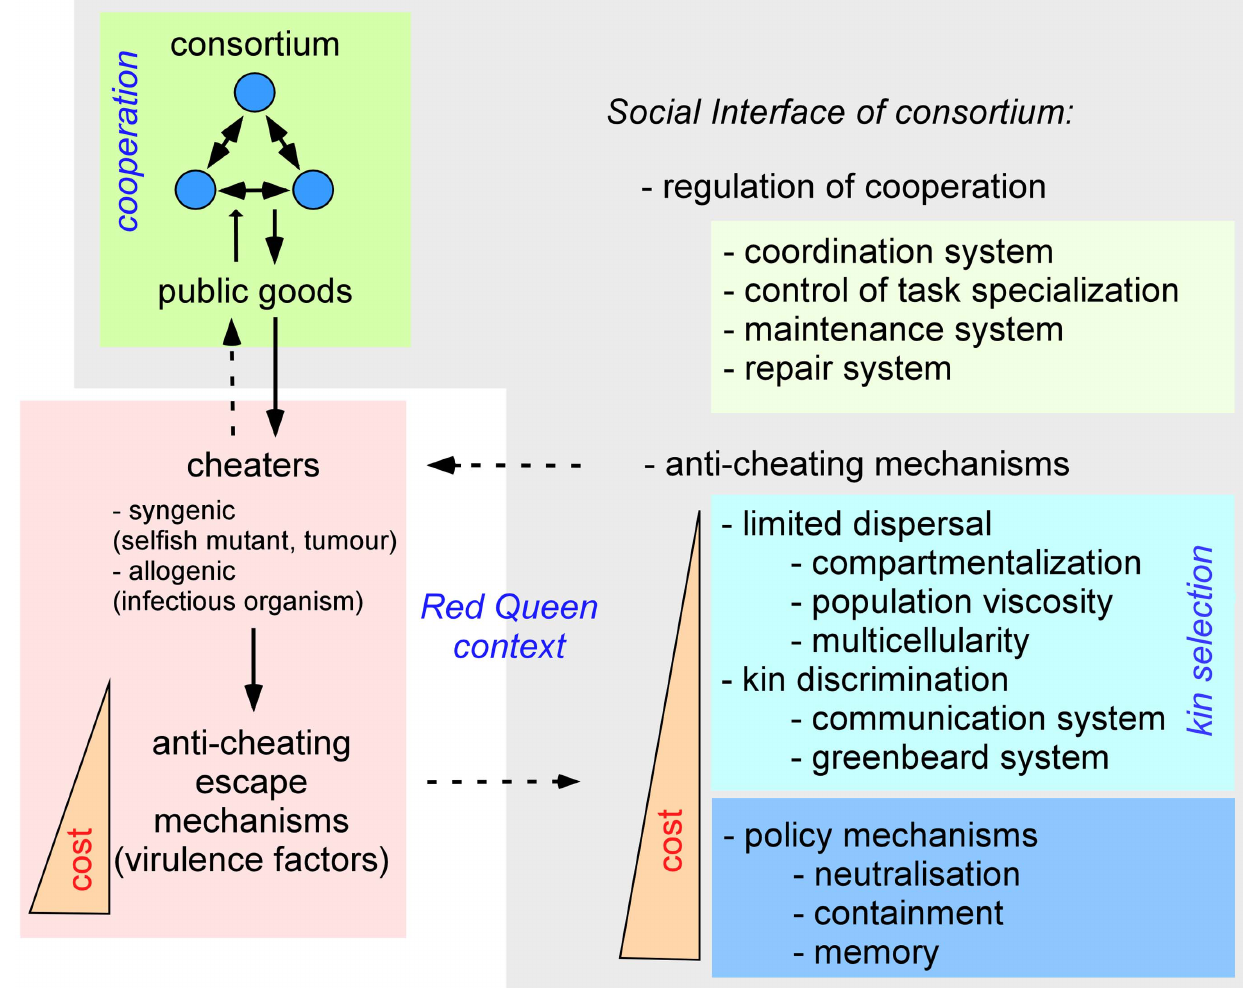
Figure 2. Role of the social interface in consortia. The social interface (SI) appears to be responsible for management of the cooperation of syngeneic cells in consortia, detection of selfish/cheater behavior of syngeneic or allogeneic cells, and control and memorization of cheaters. To escape policing mechanisms of SIs, cheaters develop anticheating escape mechanisms, leading to ‘‘Red Queen’’ antagonistic coevolution.